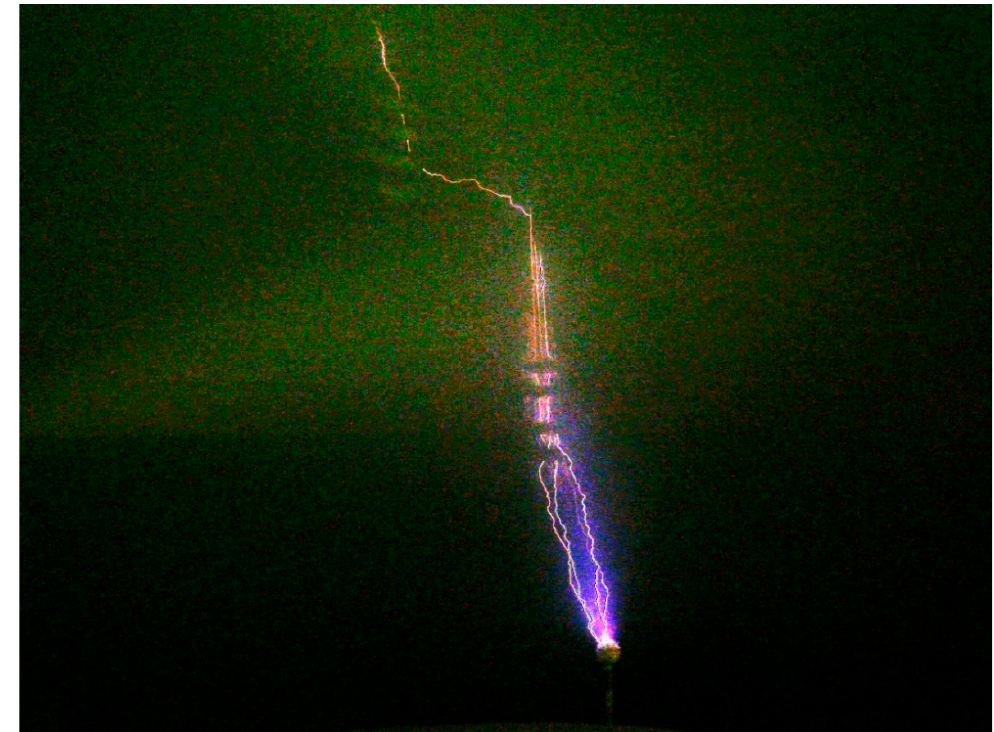
Figure 9. Discharge formation between the system of artificial positively charged thunderstorm cells and the ground involving the lower and upper groups of model hydrometeors.